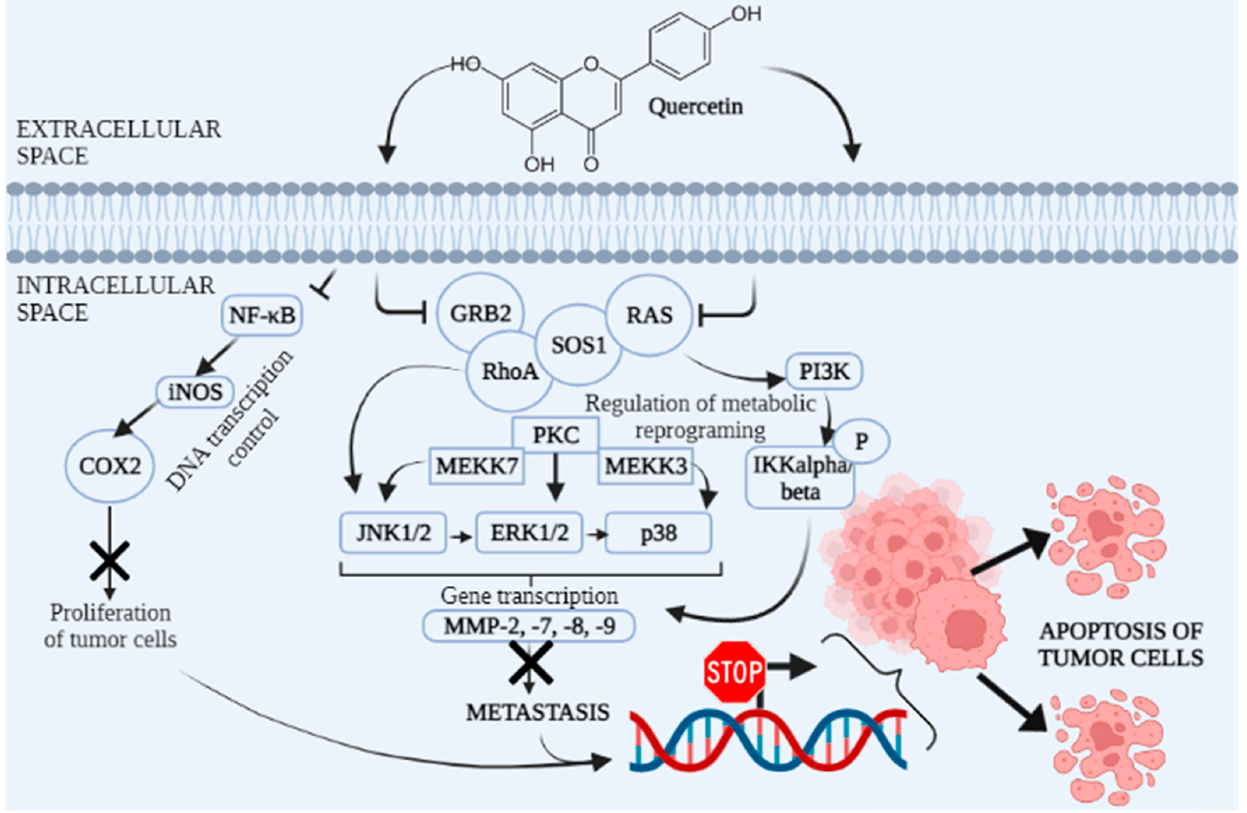
Figure 3. Scheme of quercetin antitumor mechanisms of action. NF- κ B (Nuclear factor kappa-light-chain-enhancer of activated B cells)-iNOS (Inducible nitric oxide synthase)-COX2 (Cyclooxygenase 2) is an inflammatory signalling pathway which is blocked by quercetin induction in the tumour cell. It results in blockade of proliferation of tumour cells. Moreover, quercetin inhibits interaction of GRB (Growth factor receptor-bound protein), RhoA (Ras homolog family member A), SOS1 (Son of Sevenless 1) and RAS (Rat sarcoma virus), which prevents further metabolic reprograming. That includes inhibition of other metabolic molecules; PKC (Protein kinase C), MEKK-3, -7 (Mitogen-activated protein/ERK kinase -3, -7), JNK1/2 (c-Jun N-Terminal Protein Kinase 1/2), ERK1/2 (Extra- cellular signal-regulated kinase 1/2), p38 (Mitogen-activated protein kinase), PI3K (Phosphoinosi- tide 3-kinase), IKKalpha/beta (Inhibitor of nuclear factor kappa-B kinase subunit beta) and, ulti- mately, further genetic transcription through MMP-2, -7, -8, and -9 (Matrix metalloproteinases). Fi- nally, these events lead to tumour cell apoptosis.